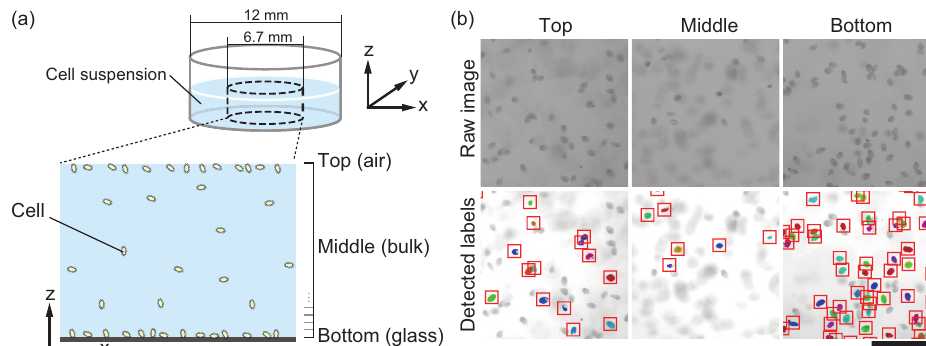
Figure 1. ( a ) Schematics of the experiment. T. pyriformis in a pancake-shaped region was observed. ( b ) Typical images captured by the microscope at different heights (top). The distribution of cells in the solution was captured every 50µm from the bottom surface. The machine learning tool systematically recognized and counted only the cells on the focal plane (bottom). The scale bar is